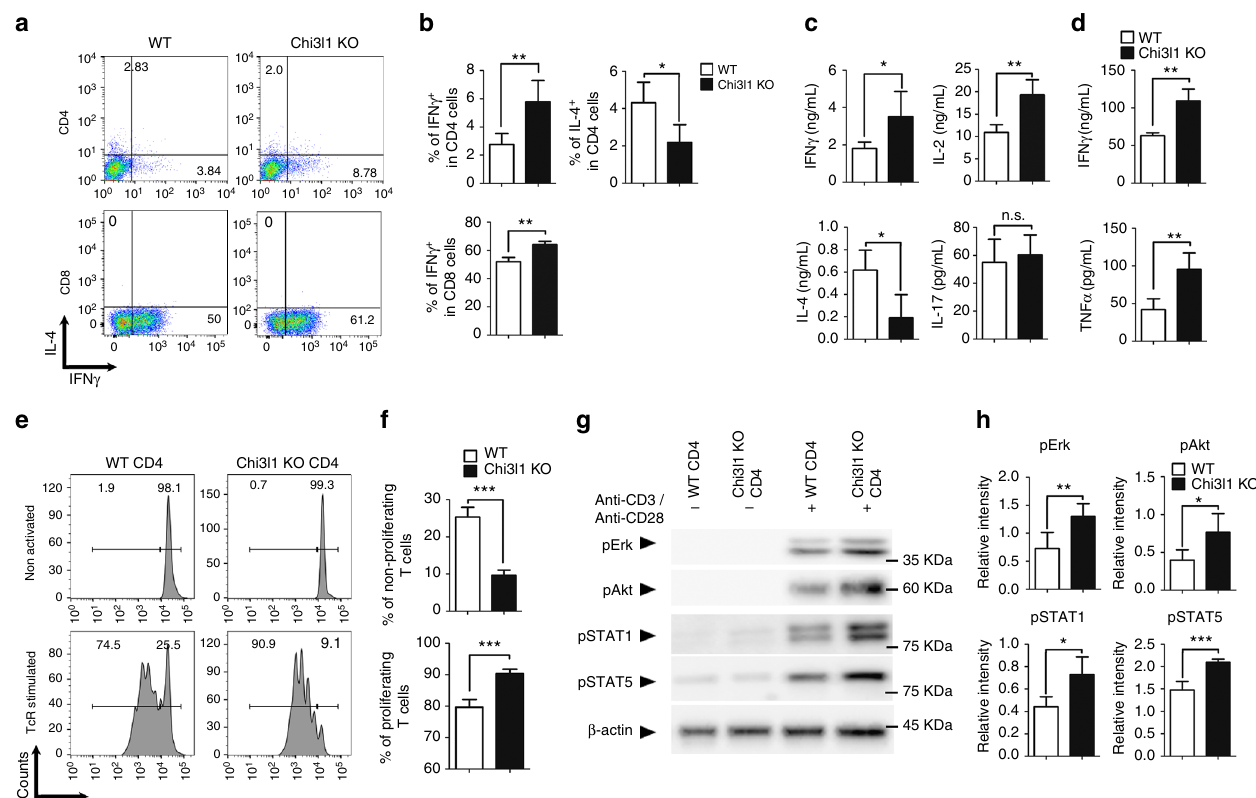
Fig. 2 Chi3l1 KO T cells are hyper-responsive to TcR stimulation. a , b MACS-sorted WT and Chi3l1 KO naïve CD4 T cells were activated by plate-bound anti-CD3 and anti-CD28 antibodies for 3 days. IFN γ and IL-4 expression level was analyzed by fl ow cytometry. c IFN γ , IL-2, IL-4, and IL-17 cytokine production in the CD4 T cell culture supernatant was measured by ELISA. d IFN γ and TNF α cytokine production in the CD8 T cell culture supernatant was measured by ELISA. e Proportion of proliferating CD4 T cells were analyzed by CFSE assay. f Percentages of proliferating and non-proliferating cells were analyzed by gating on histogram. g Phosphorylated Erk, Akt, STAT1, STAT5 were analyzed by Western blotting. h Relative densitometric analysis of Western blots was represented as normalized to β -actin. Data are mean ± SD of three sets of independent experiments ( n = 6). n.s., not signi fi cant; * p < 0.05, ** p < 0.01, *** p < 0.001 (two-tailed Student ’ s t